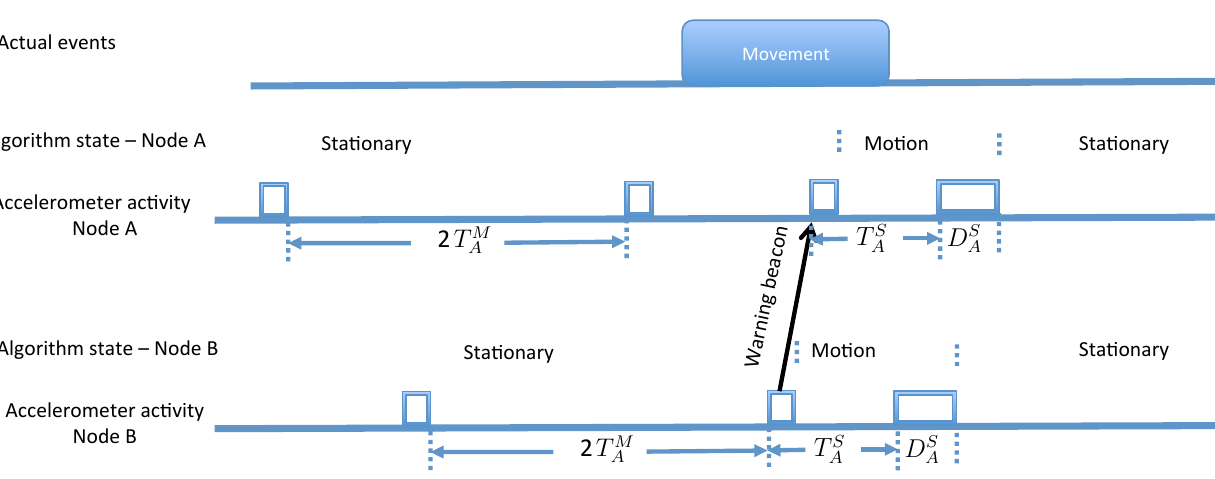
Figure 15. Group-based Accelerometer Duty Cycling showing a timeline of actual motion events, algorithm state, and the active/sleep periods of the accelerometer for two nodes A and B. Initially, both nodes are in stationary state and their accelerometers are duty cycled T M . Once node B detects motion, it sends a warning beacon to node A with a period of 2 A ∗ and switches to the motion state. When node A receives the warning beacon, it samples its accelerometer and detects that it is moving, so it also switches to its motion state.